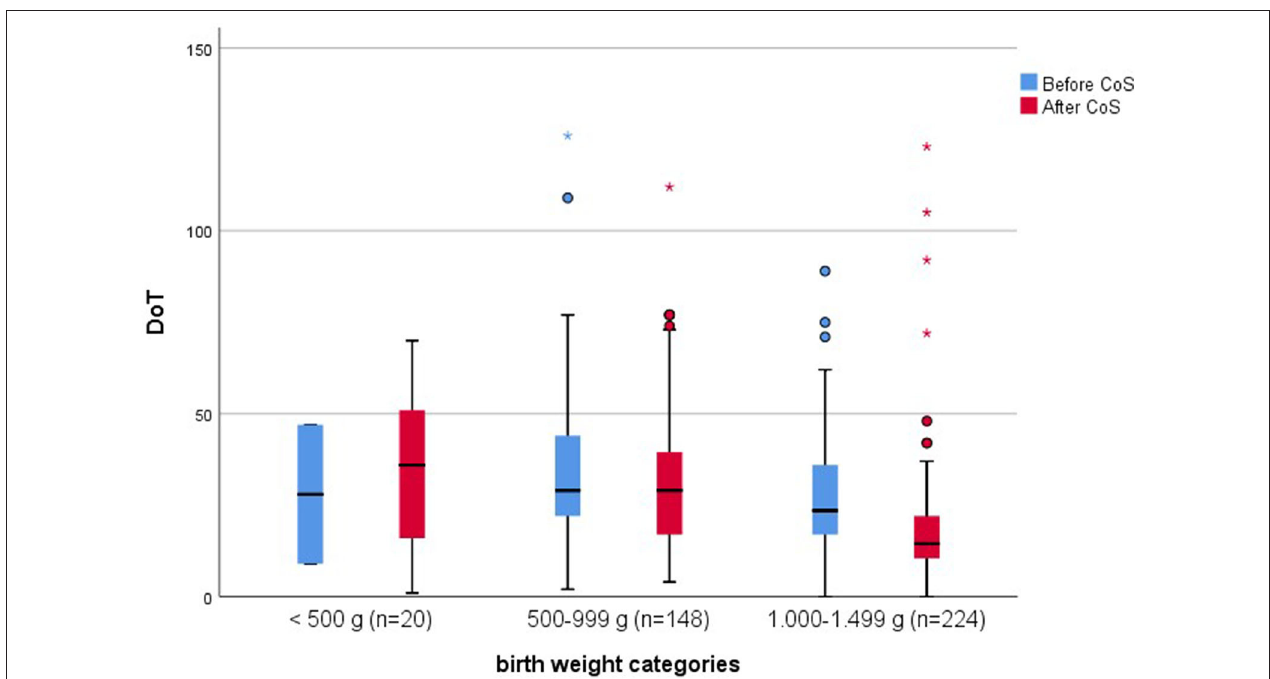
FIGURE 1 | Comparison of total days of therapy (DoT; i.e., sum of DoT per antibiotic substance) between the two cohorts before and after the introduction of colonization screening, stratified by categories of birth